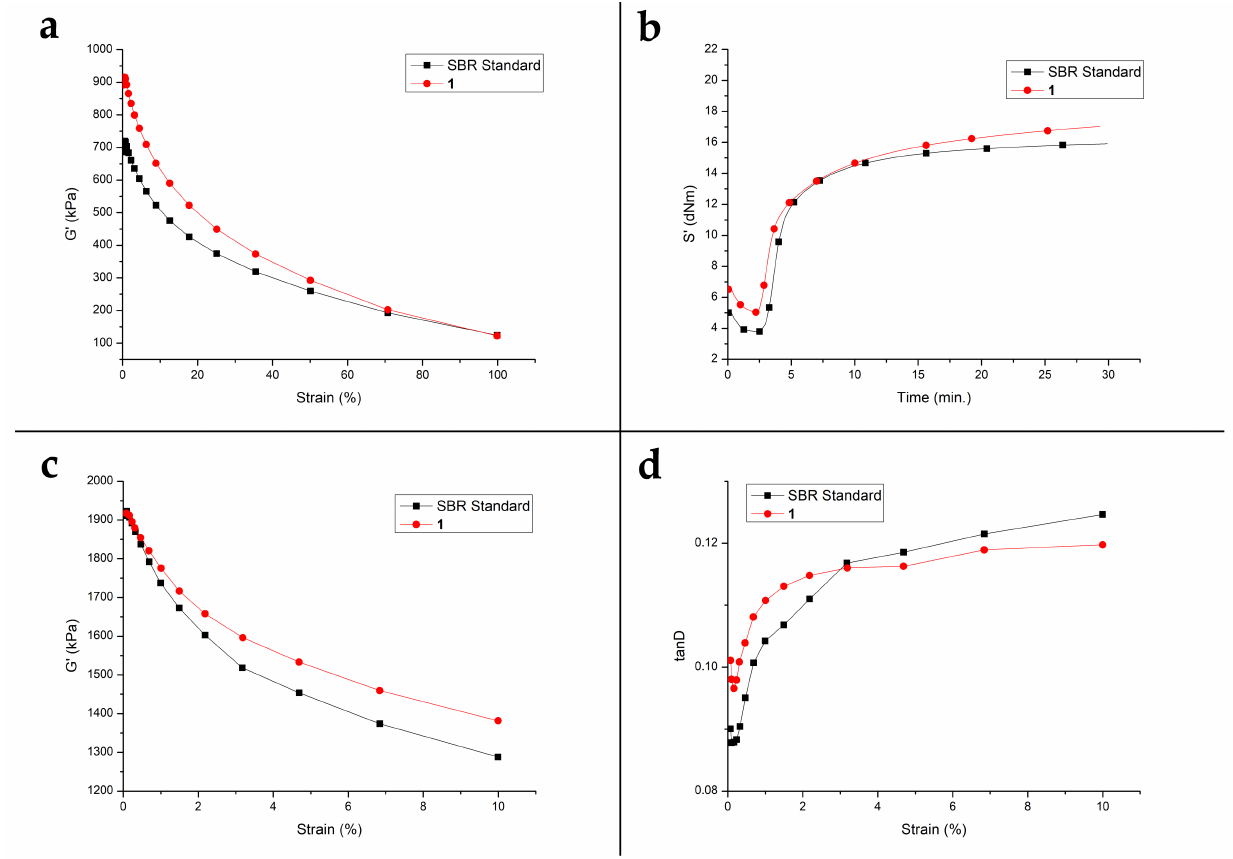
Figure 6. Dynamic mechanical properties of final compound treated with bistetrazole 1 compared to final standard SBR. ( a ) G’ measured before curing; ( b ) S’ at 190 ◦ C; ( c ) G’ measured after curing at 190 ◦ C; ( d ) tan delta after curing at 190 ◦